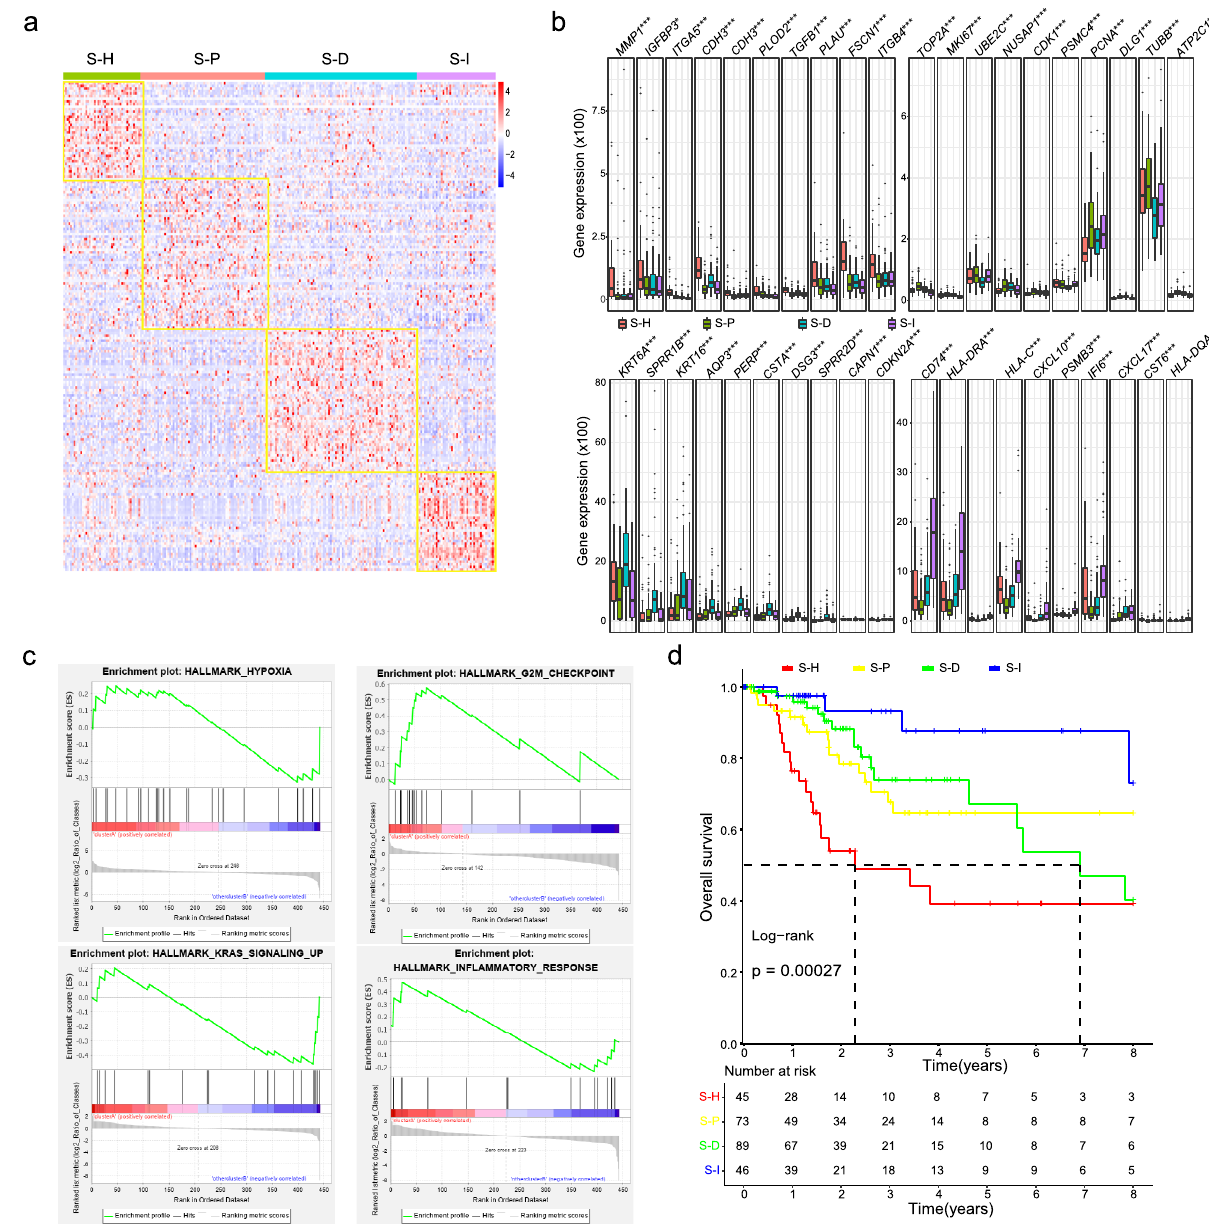
Fig. 5 Differences among the four CC subtypes. a Subclusters of CC samples based on signature genes from scRNA-seq data. b Bar plots showing the comparisons of expression levels of representative subcluster markers genes across different subclusters. c GSEA enrichment of signature genes in each CC subtype. d Survival differences among the four subclusters in CC samples. * P < 0.05, * P < 0.01, *** P <